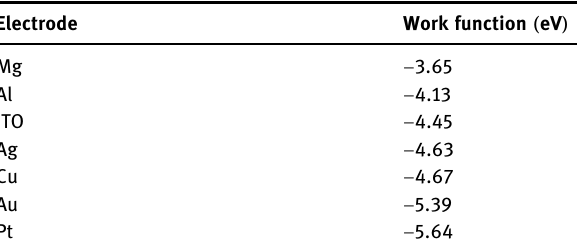
Table 5: Work function of typical electrodes used in the bio - organic - based RRAM [ 18